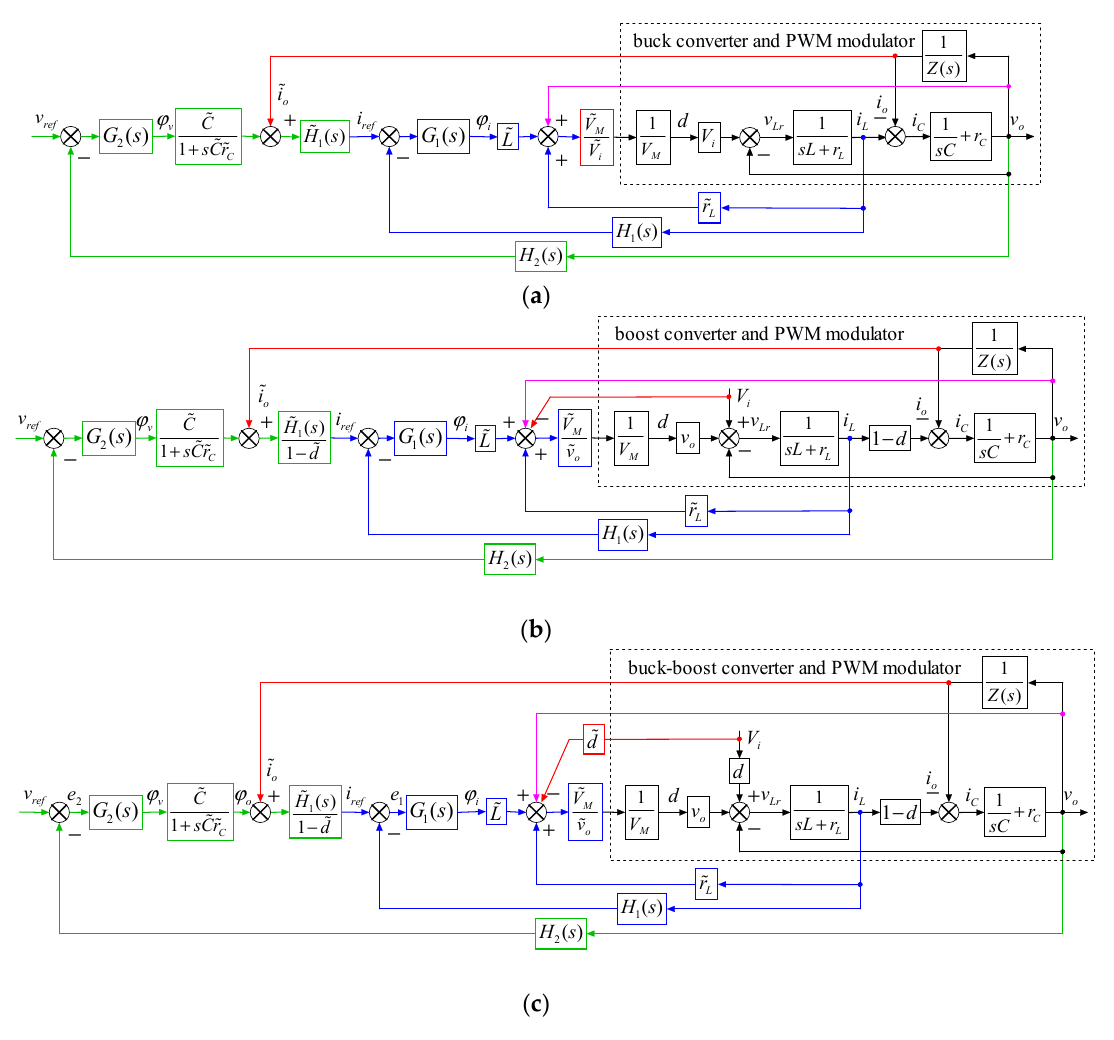
Figure 3. Block diagrams of the inverse-system decoupling control systems for DC/DC converters: ( a ) buck converter; ( b ) boost converter; ( c ) buck–boost converter.